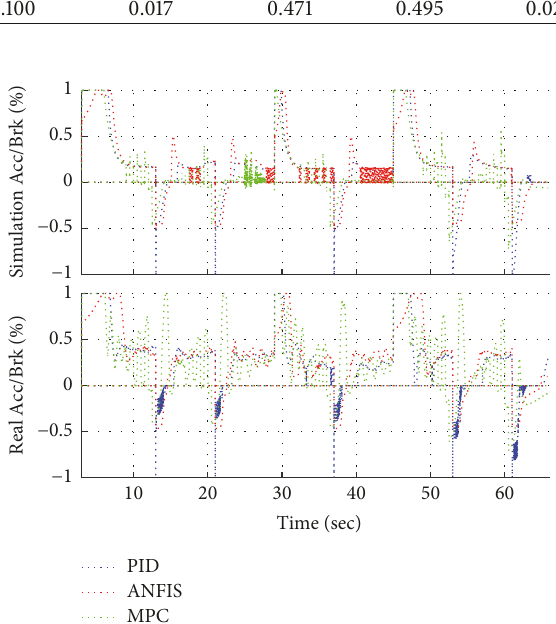
Figure 12: Controller output: simulation and real